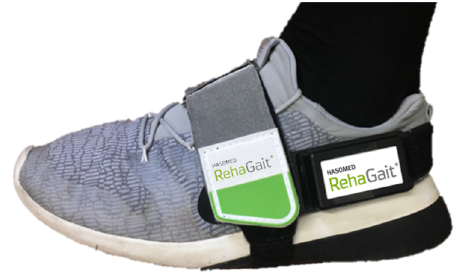
Figure 12. Reference sensor with fixation strap.